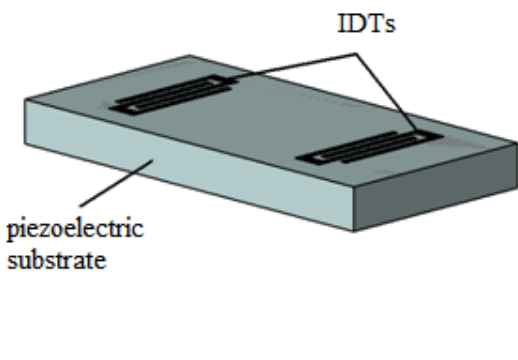
Figure 12. Scheme of a SH-SAW